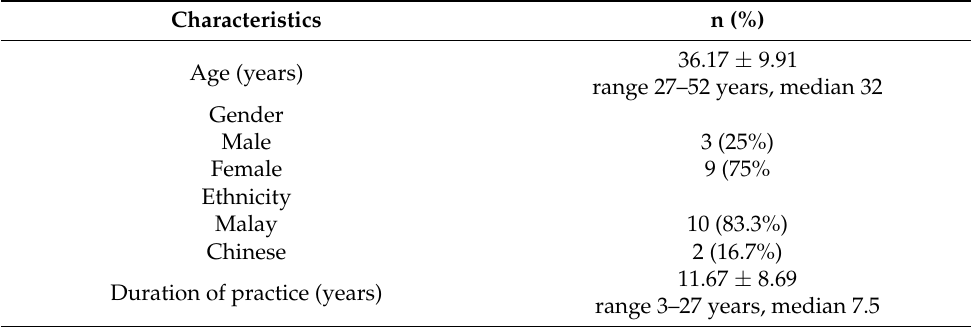
Table 4. Socio-demographics of the GDPs who participated in the study, n =